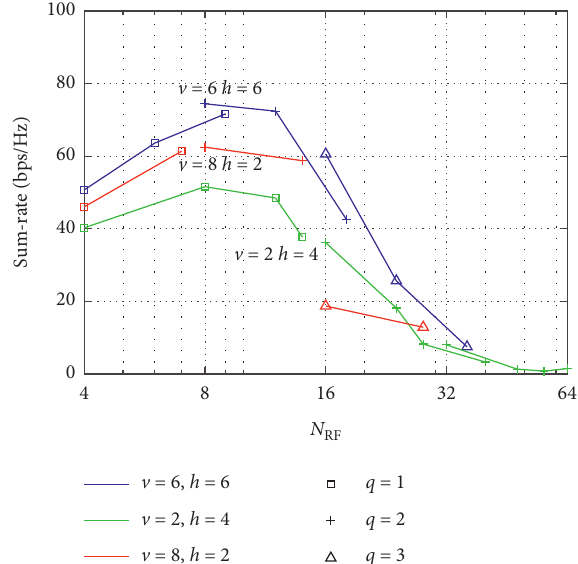
Figure 6: Sum-rate versus the number of RF chains for different multiplicity factors.